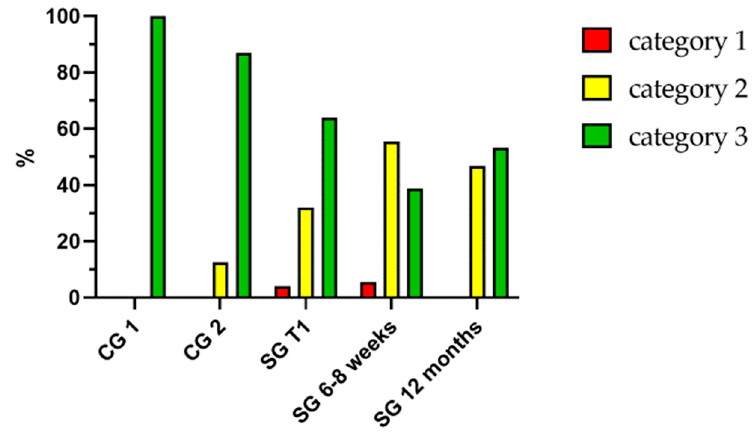
Figure 4. MNA (Mini Nutritional Assessment) categories of CG 1, CG 2 and SG at set time points. Category 1: malnourished ( < 17 pts.), category 2: risk of malnutrition (17–23.5 pts.) and category 3: well-nourished (24–30 pts.).